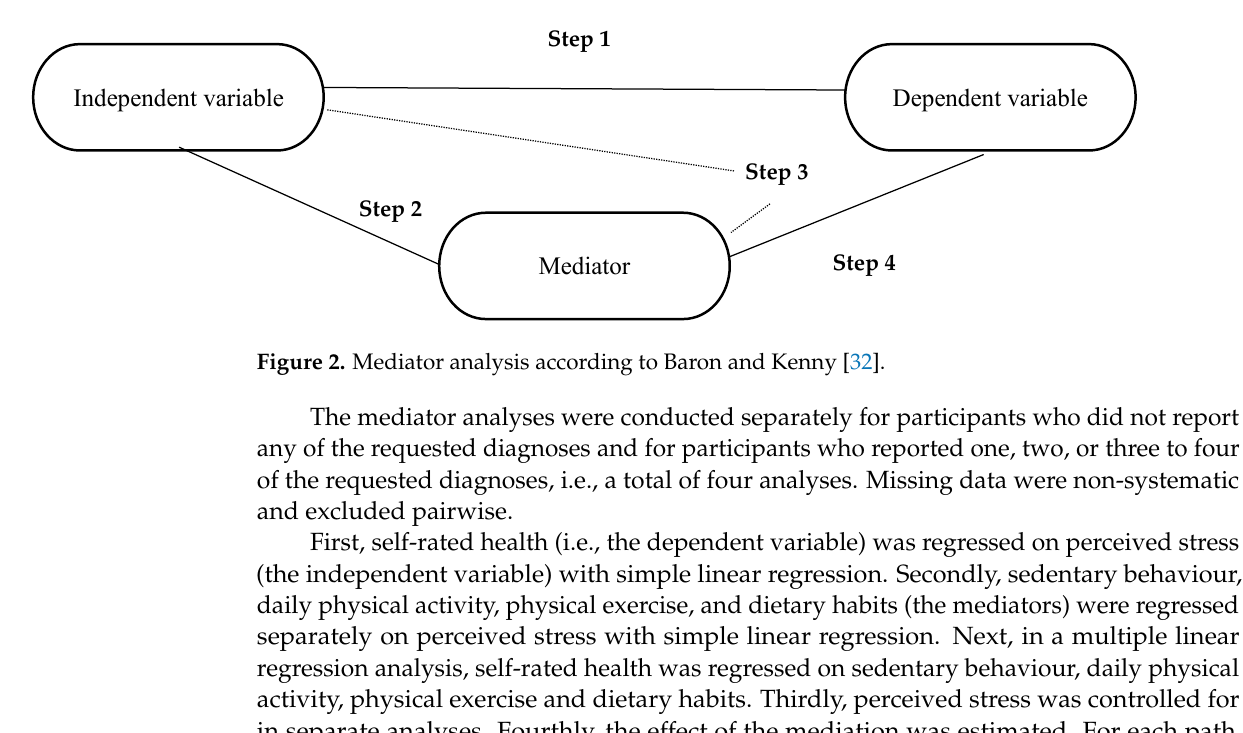
Table 2. Distribution of responses in the two data sets (2016, 2019) and in the total sample.